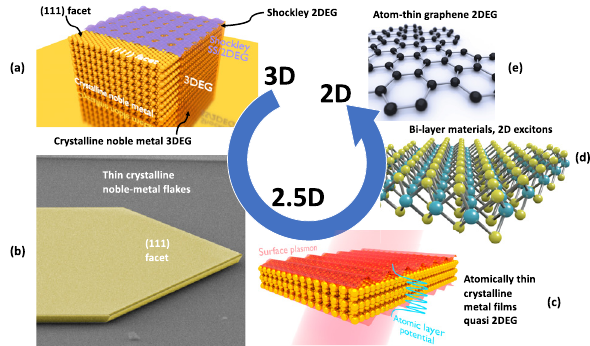
Figure 16: Illustration of the materials paradigm oftransdimensional photonics [342], with the electrodynamics spanning the plasmonic response of both the 3DEG and 2DEG systems. Material realizations include (a) 3D crystalline metals, (b) quasi-2D crystalline metal films [320, 343], (c) atom-thin metal films [344, 345], (d) layered 2D exciton materials [32, 346], and eventually (e) one-atom thin 2D materials [30, 67]. The support of a 2DEG by Shockley surface states, closely analogous to the 2DEG in graphene, is closing the circle of this new emerging materials paradigm. 2DEG, two-dimensional electron gas; 3DEG, three-dimensional electron